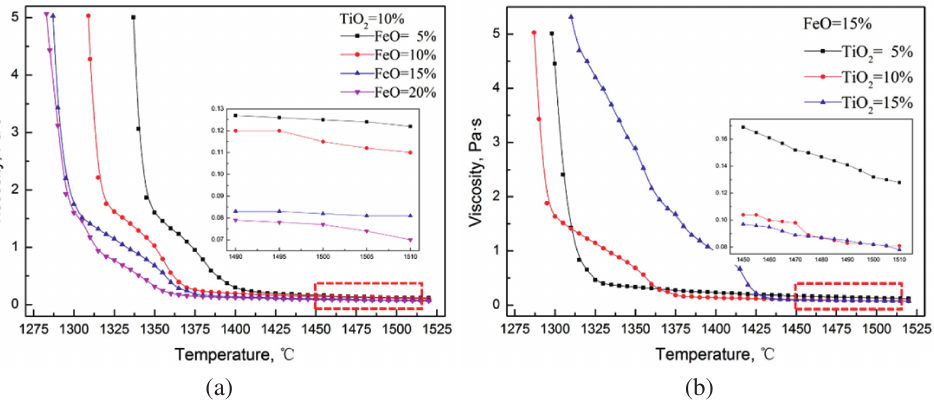
Figure 5: Viscosities of CaO – SiO 2 – Al 2 O 3 – MgO – FeO-TiO 2 systems at C/S = 1.32 by varying the FeO and TiO 2 contents as a function of temperature: (a) FeO = 15 wt%; (b) TiO 2 = 10